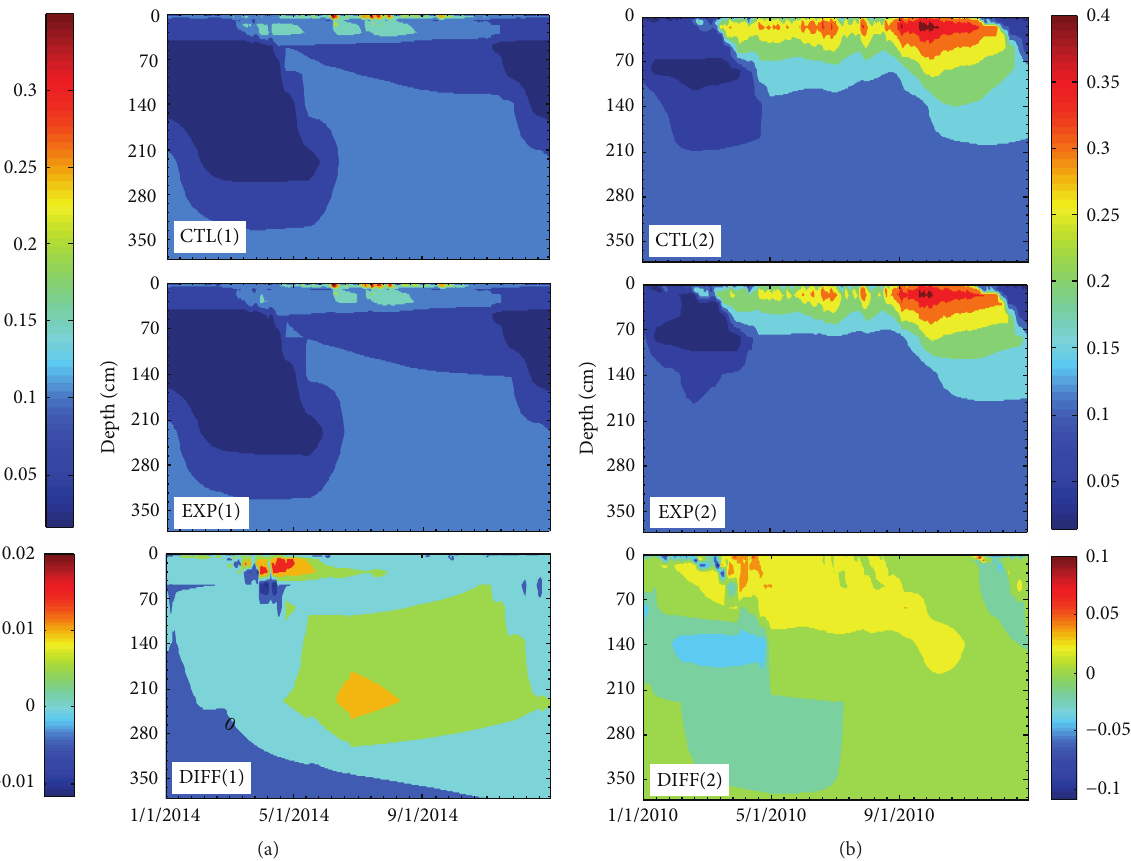
Figure 3: Profile of soil moisture differences (DIFF, CTL minus EXP) at different sites ((a) GS, (b) ZS).